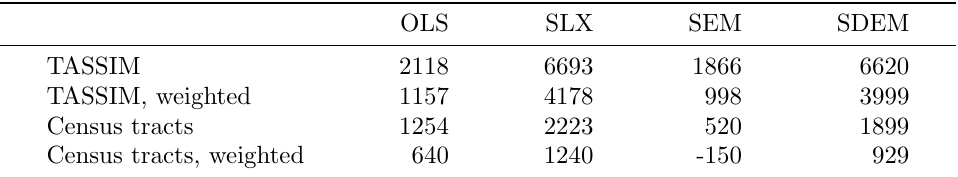
Table 3: WTP for a one pphm reduction in NOX in 1970 USD (mean difference between base prediction and prediction with NOX reduced by 0.1 parts per ten